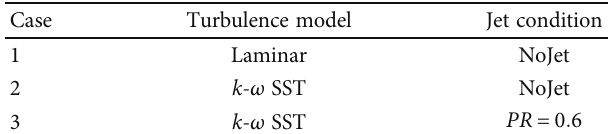
Table 3: Cases for